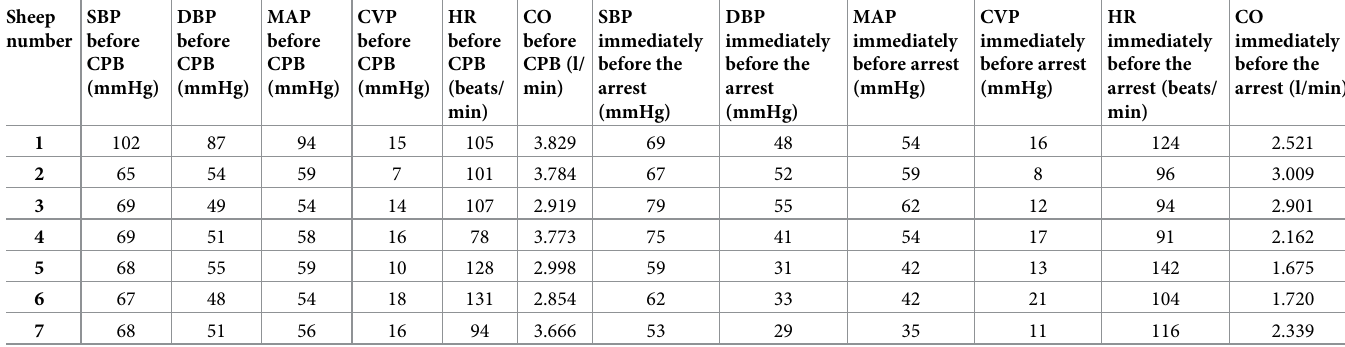
Table 2. Haemodynamic characteristics of all animals.